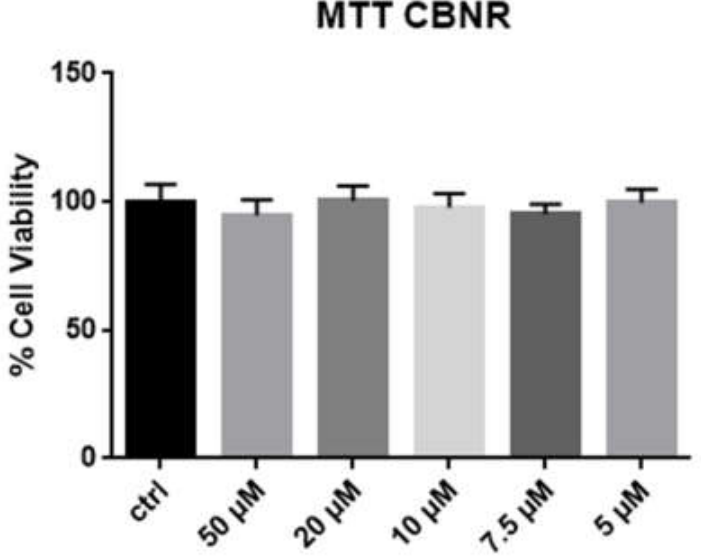
Figure 2. Results of cell viability after incubating NSC-34 cells with different concentrations of CBNR. MTT test indicates that CBNR is not toxic to cells after 24 h of incubation.